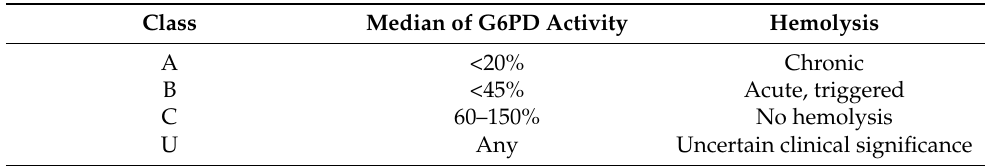
Table 1. WHO classification of G6PD